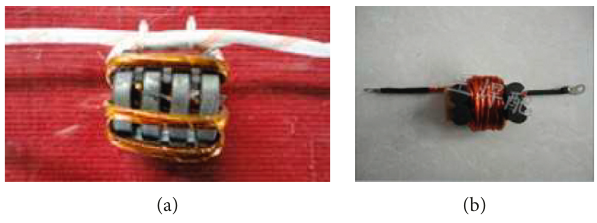
Figure 25: Resonant inductor and commutation inductor.